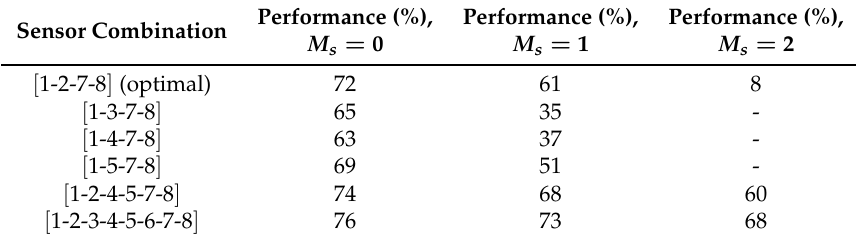
Table 2. Performance of different sensor combinations for the panel depicted in Figure 4 without ( M s = 0) and with ( M s = 1,2) sensor malfunctioning. Performance (%), Performance (%), Performance (%), Sensor Combination M s = 0 M s = 1 M s =